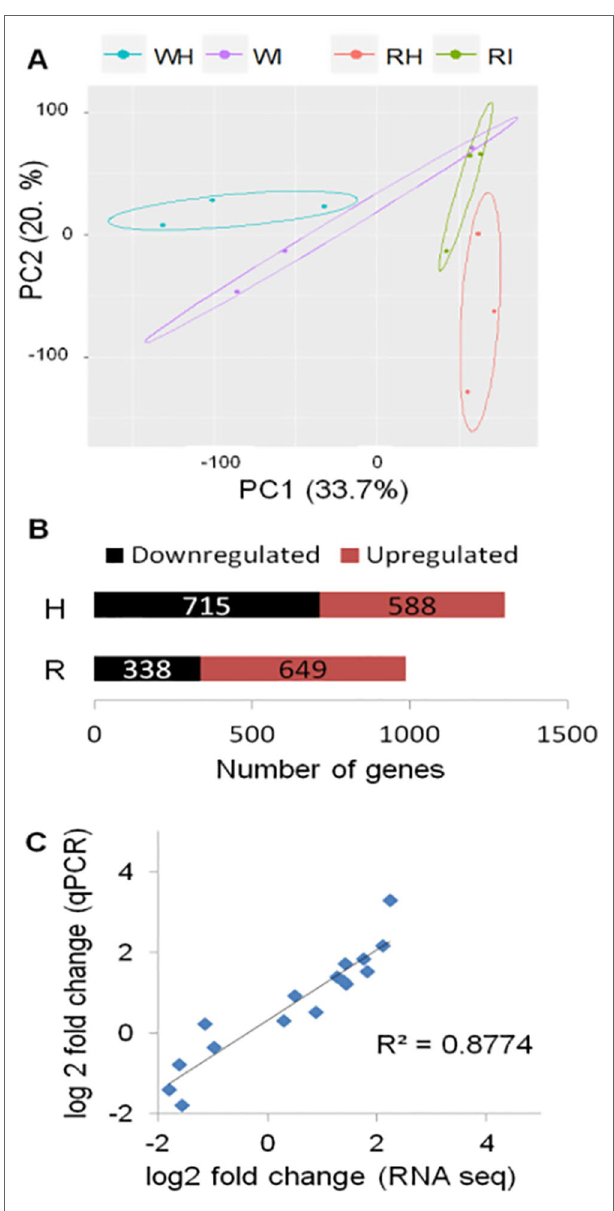
FIGURE 2 | Global evaluation of the RNA-seq data and of the differentially expressed (DE) genes at 24 h postinoculation (hpi). (A) Principal component analysis displaying the biological variations of Fragaria vesca genes among samples. W, white fruit; R, red fruit; H, healthy (mock inoculated); I, Botrytis cinerea inoculated. Raw count data were used after precision weight was calculated by the voom method (Law et al., 2014). (B) Number of DE genes ( P < 0.05, absolute fold change >1.74) upon B. cinerea inoculation at 24 hpi; downregulated genes (black) and upregulated genes (red). (C) Comparison of gene expression values of RNA-Seq and qRT-PCR: correlation of fold change values for eight F. vesca genes obtained by RNA-Seq and